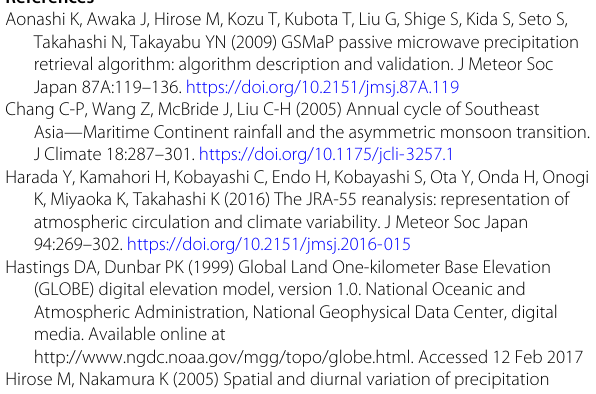
Additional file 1: Figure S1. Showing the robustness of the horizontal distribution of GSMaP performance shown in Fig. 5. (a) As for Fig. 5c–e. The left, center and right panels correspond to Fig. 5c, d, and e, respectively. (b–i) Same as Figure S1a, but for the (left) southerly, and (center) westerly wind, at the 850 hPa level, for eight grid points over and around northern Vietnam, in the JRA-55, and (right) the difference ((center) minus (left)). The eight grid points are shown on the map with the 1.25 ◦ × 1.25 ◦ lattice, at the upper right. (PDF 12,276